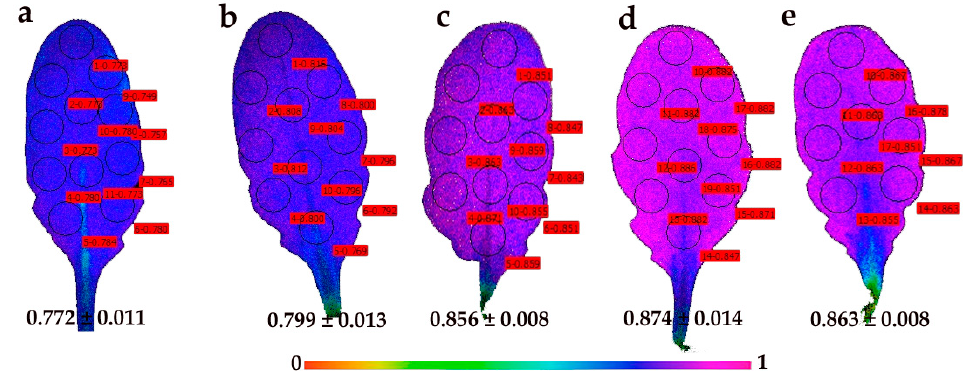
Figure 10. Representative chlorophyll fluorescence images of the relative reduction state of the plastoquinone (PQ) pool—that is, the photochemical fluorescence quenching, reflecting the fraction of open PSII reaction centers ( q P ) of Arabidopsis thaliana mature leaves after 5 min of illumination at 140 µ mol photons m − 2 s –1 . Leaves were measured after the foliar spray with distilled water (control) ( a ), or 30 min ( b ), 90 min ( c ), 180 min ( d ) and 240 min ( e ) after the foliar spay with 30 mg L − 1 of CuZn NPs. The color code depicted at the bottom of the images ranges from values 0.0 to 1.0. The areas of interest (AOI) are shown in each image. The average q P value of all the AOI for the whole leaf is shown.